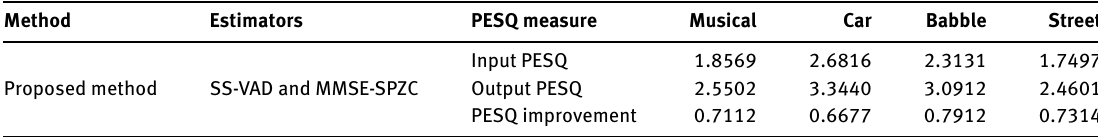
Table 11: Performance Measurement of Combined SS-VAD and MMSE-SPZC Estimator in Terms of PESQ for Kannada Database. Method